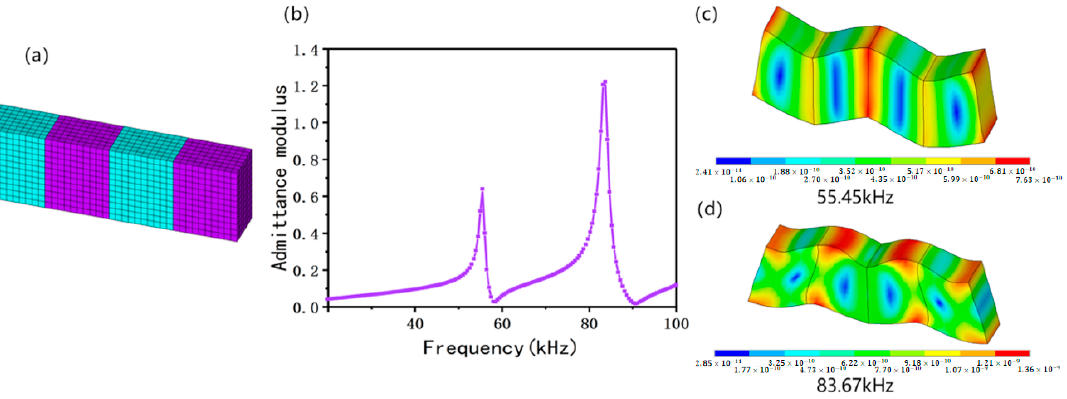
Figure 4. Finite element simulation results on bonding of four elements. ( a ) Mesh model; ( b ) admittance modulus curve; ( c ) vibration mode @55.45kHz; ( d ) vibration mode @83.67kHz.